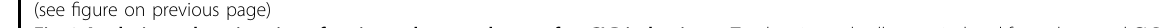
Fig. 2 Analysis on the migration of peritoneal macrophages after CLP induction. a Total peritoneal cells were isolated from sham and CLP mice. Cells were stained with anti-B220 and anti-CD11b antibodies or anti-VSIG4 and anti-CD11b antibodies, and analyzed by fl ow cytometry. b CLP was induced in mice and after 24 or 48 h, immune cells were isolated from the peritoneal cavity, spleen, thymus, and mediastinal lymph nodes. Cells from sham mice were used as control. Cells were stained with VSIG4 and CD11b antibodies, and analyzed by fl ow cytometry. c CD11b + cells in thymus from sham and CLP mice (24 and 48 h) were counted. d Peritoneal macrophages were isolated and stained with VivoTracker, and then injected into the peritoneal cavities of sham (left) or CLP mice (right). After 24 h, the mice were euthanized, and the peritoneal cavity was washed with PBS several times, and then analyzed with an In Vivo Imaging System (IVIS Spectrum). e Organs containing thymus were isolated from sham or CLP mice and analyzed with an in vivo imaging system (IVIS Spectrum). f Immune cells were isolated from the peritoneal cavity and thymus of mice as shown in ( d ), and the fl uorescence intensity of the cells was analyzed by fl ow cytometry. g Number of VivoTracker positive cells from peritoneal cavity and h thymus as shown in ( e ) were counted using Alexa 700. The data represent the mean ± S.E.M. of three separate experiments. * p < 0.05, ANOVA. Per Cells indicate peritoneal cells, and Media-LN indicates the mediastinal lymph node around the